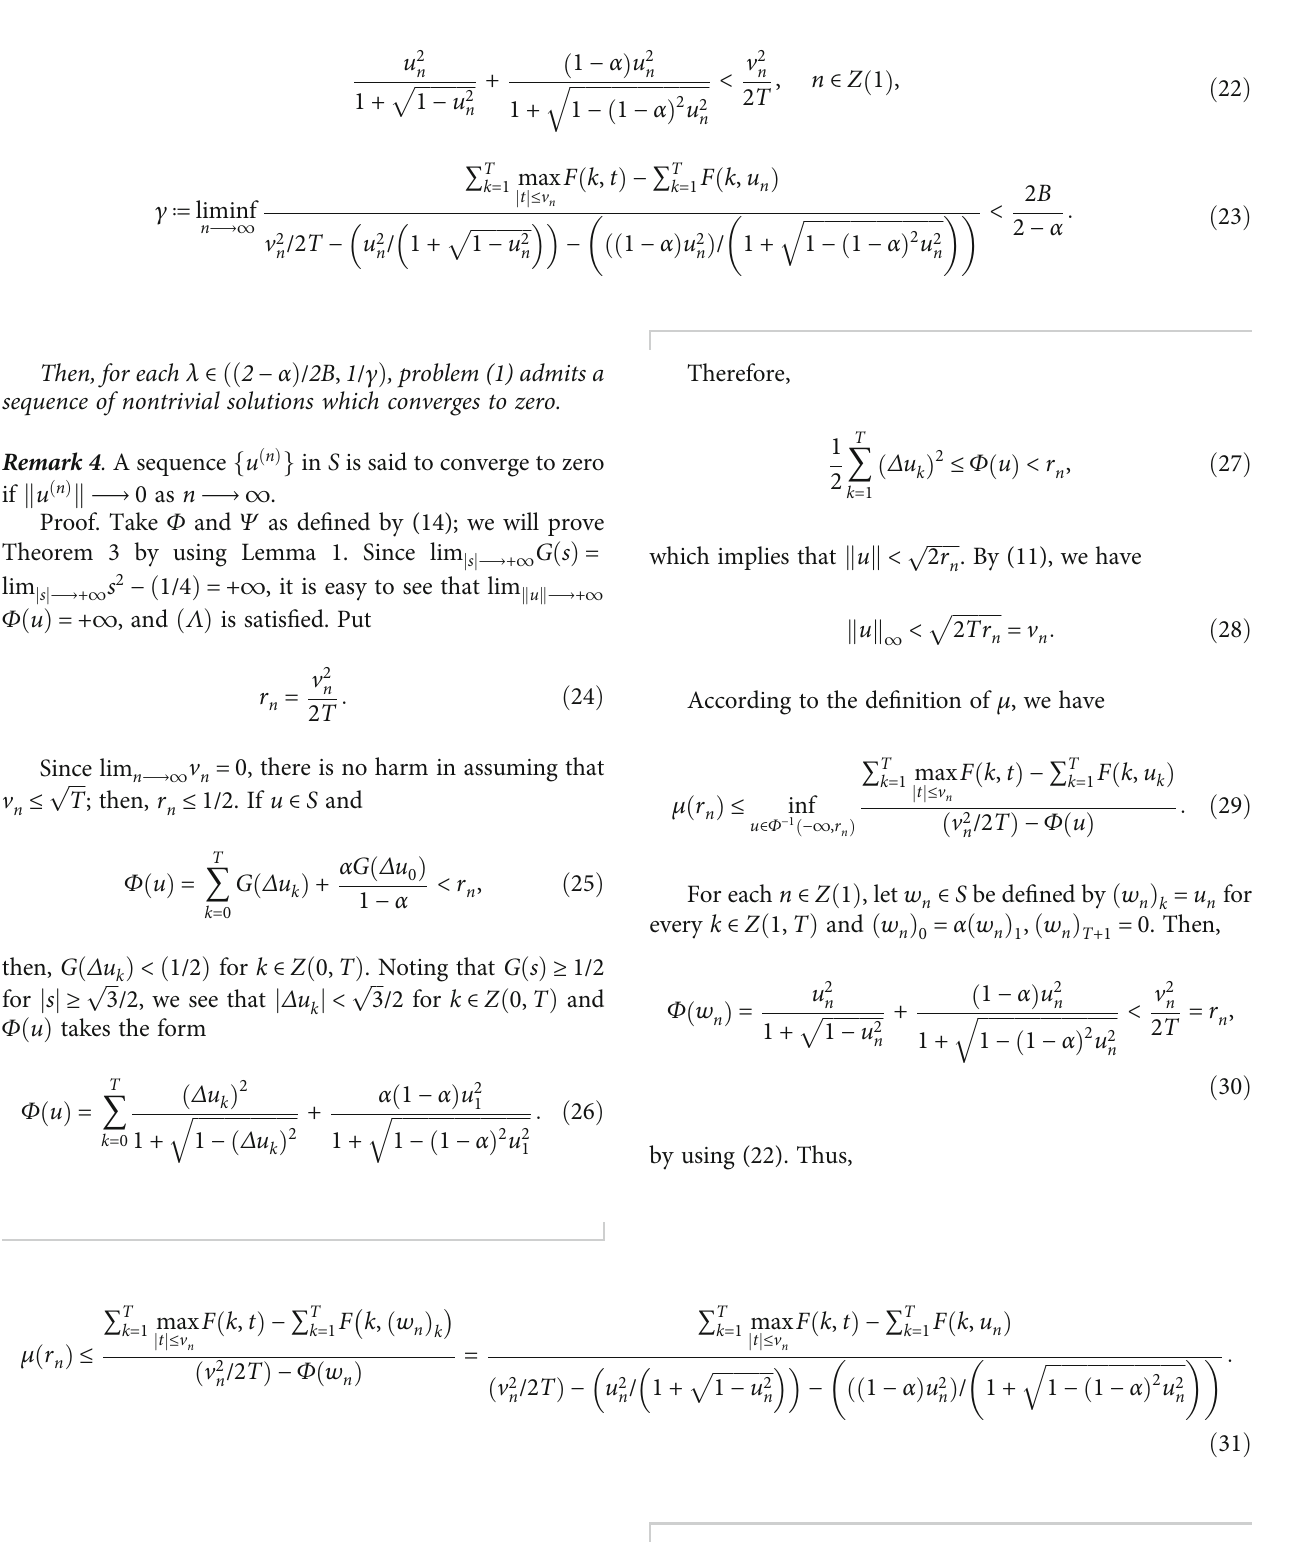
p(cid:3) (cid:4)(cid:3) (cid:4)